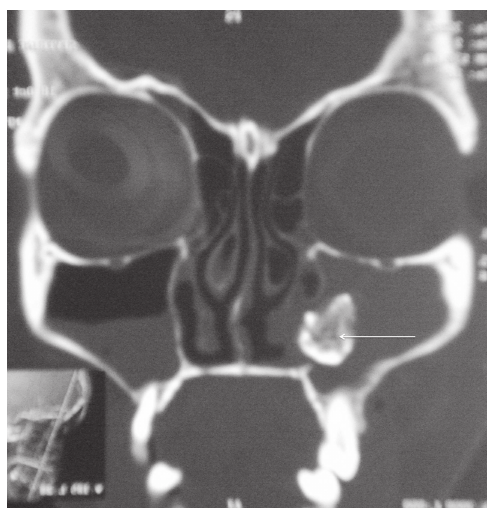
Figure 1: Coronal CT OMC showing antrolith.